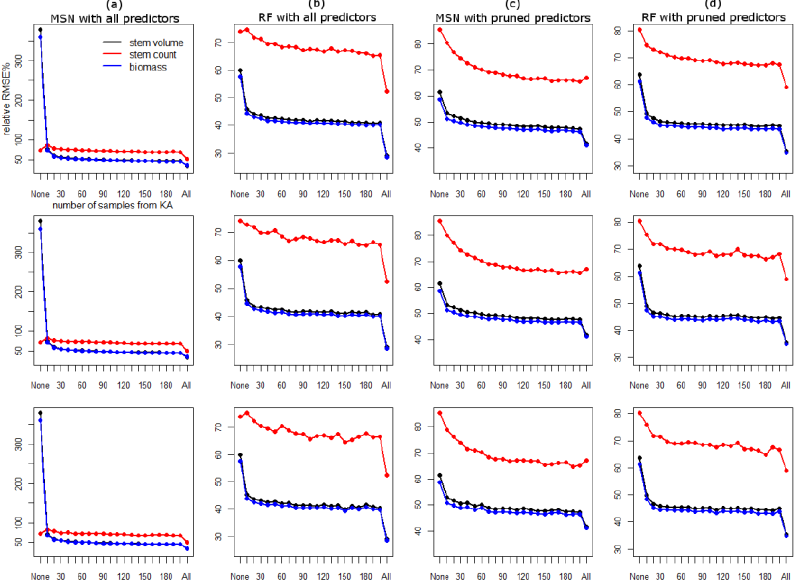
Fig.2. Relative RMSE% of NN predictions. In each row, from left to right: MSN with all predictors (a), RF with all predictors (b), MSN with pruned predictors (c), and RF with pruned predictors (d). Each column shows predictions using random (top), stratified random (middle) and systematic stratified (bottom) samples.